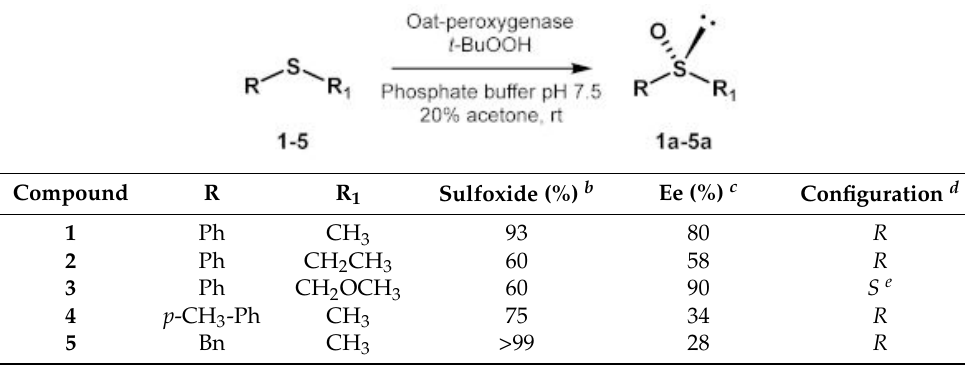
Table 1. Biocatalyzed oxidation of sulfides with oat peroxygenase a .